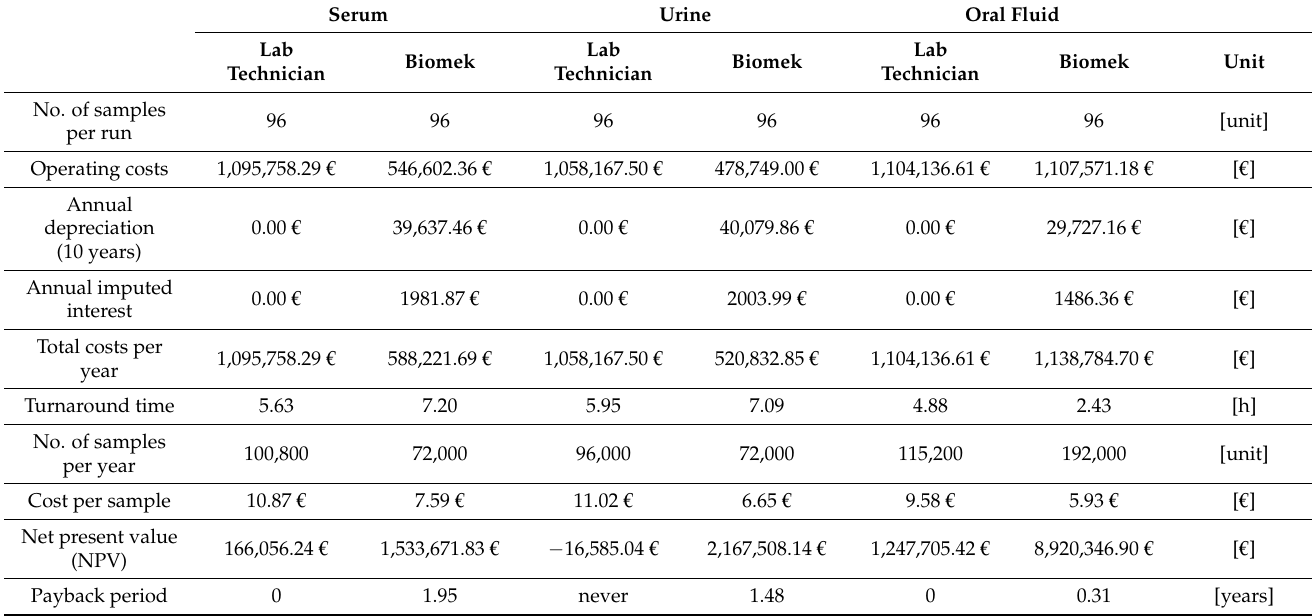
Table 4. Results of economic